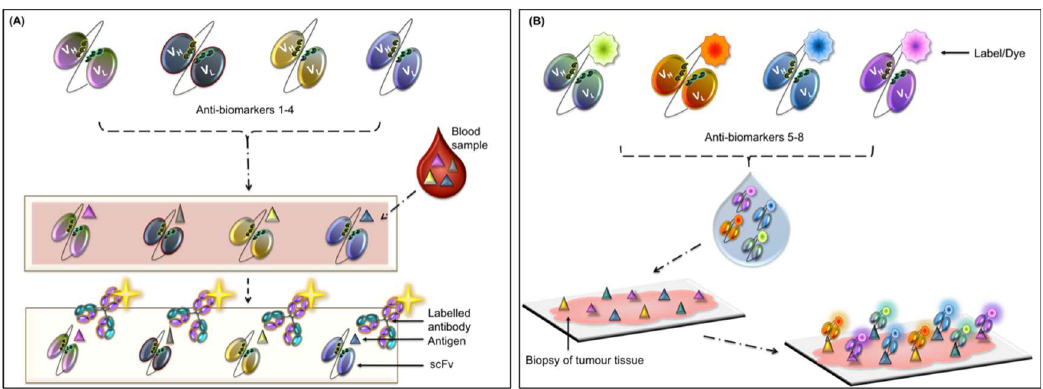
Figure 2. Schematic representation of a multi-marker panel for pancreatic cancer diagnosis. ( A ) This illustration depicts the potential diagnosis of pancreatic cancer using four recombinant antibodies (single chain fragment variable (scFv)) generated against serum antigens found in pancreatic cancer. Each antigen provides information crucial for the treatment and prognosis of the disease. ( B ) Four different scFvs against tissue markers found (or upregulated) in pancreatic cancer are coupled to different dyes or labels. These scFvs will be applied to tumor tissues obtained by a biopsy. Any antigen within the tissue will be detected by the relevant scFv and the levels of each antigen determined. (Adapted from Crawley and O’Kennedy, 2015).